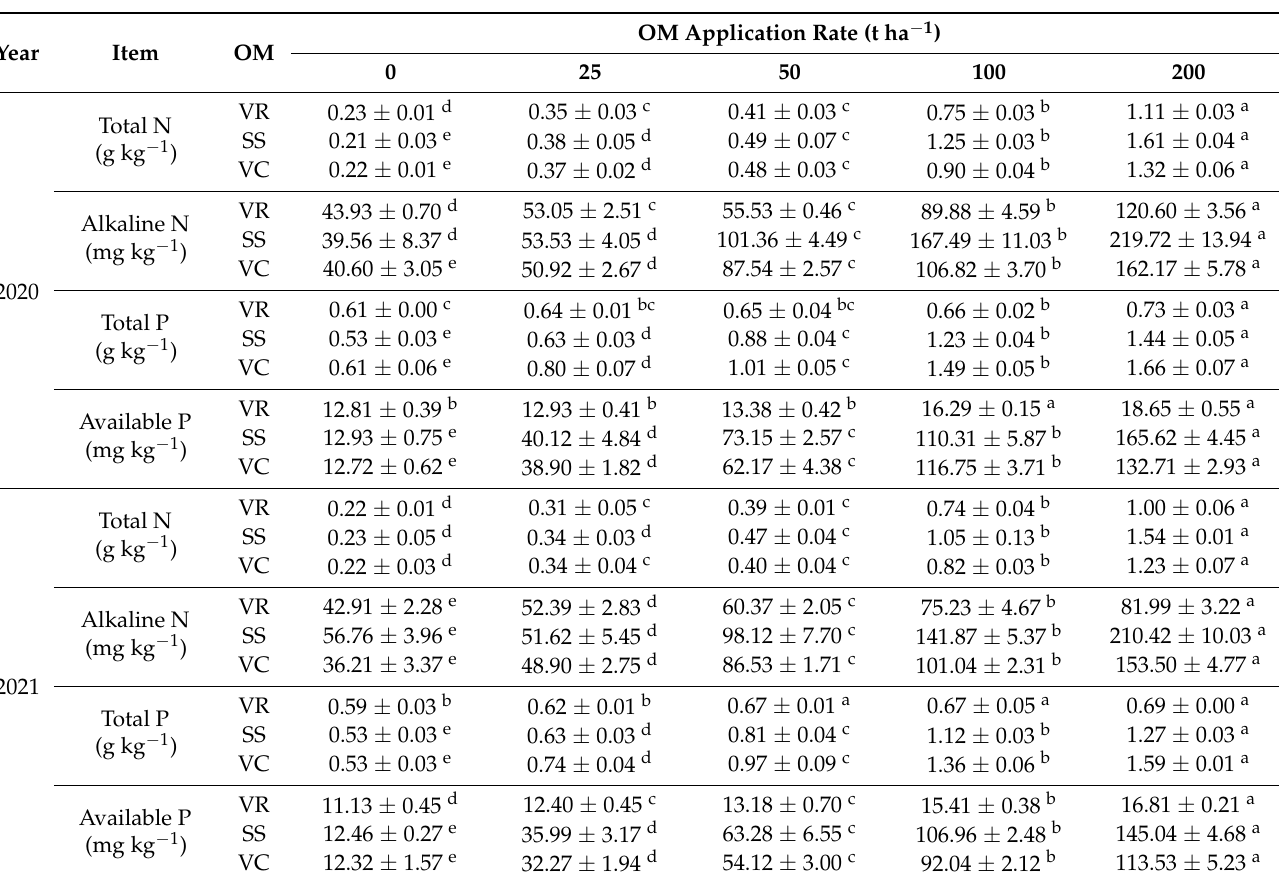
Table 2. Effects of different organic material application on nitrogen and phosphorus contents in saline-alkali